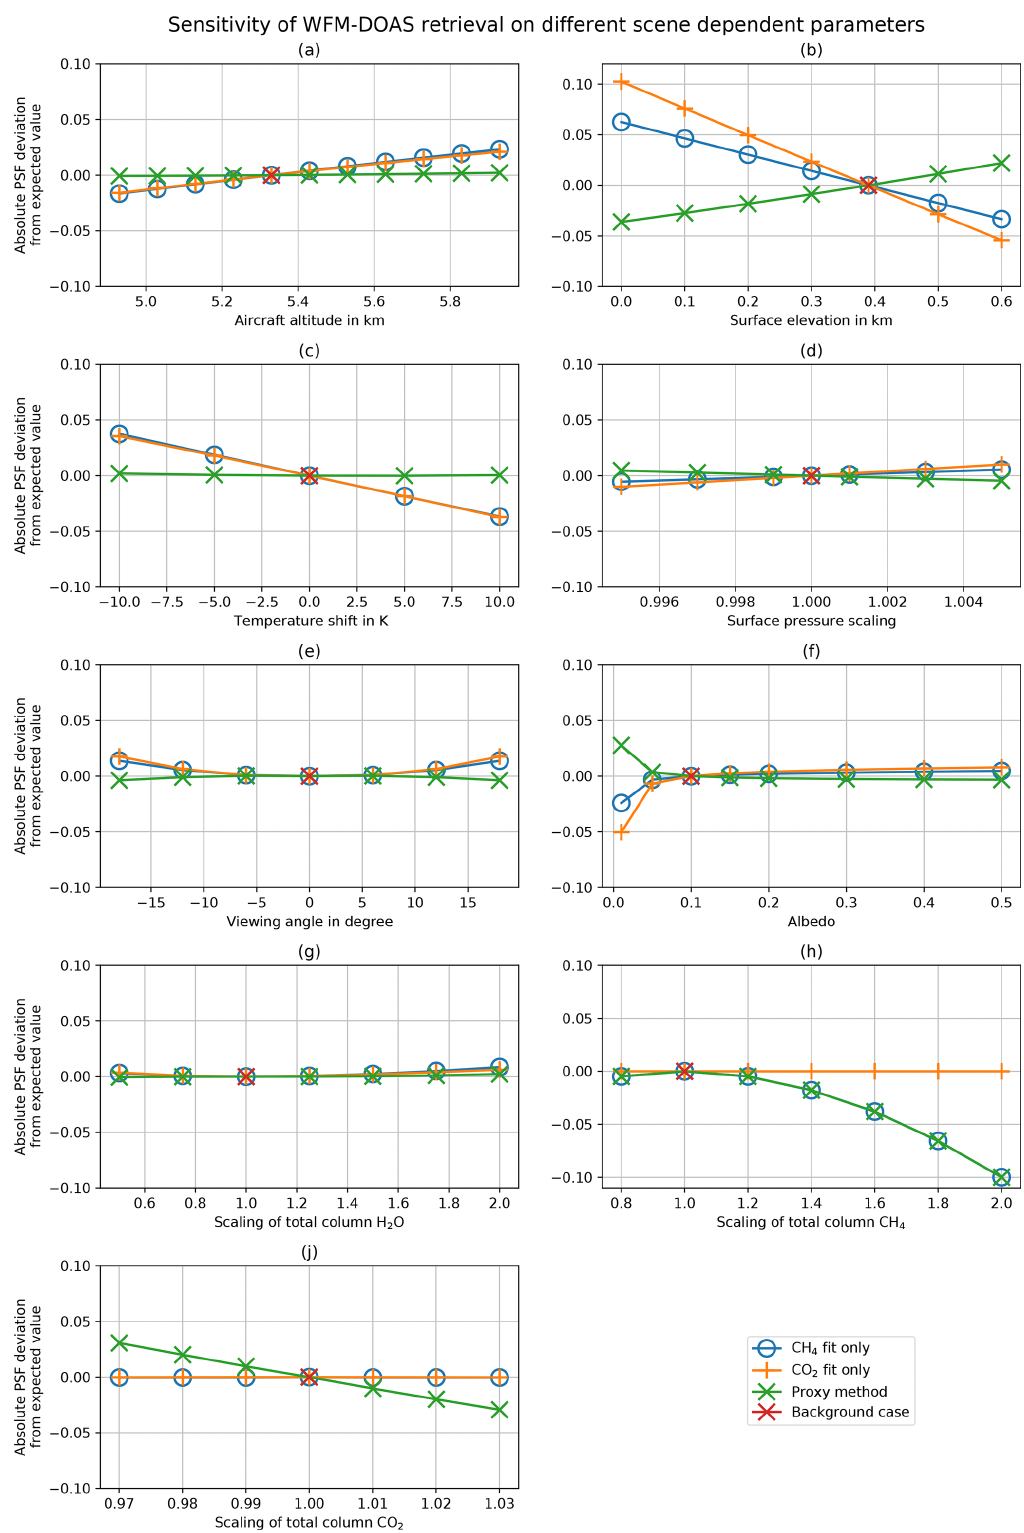
Figure 4. Sensitivity analysis of WFM-DOAS to the examined input parameters of the SCIATRAN radiative transfer calculation. The absolute deviation between the retrieved and the expected PSF CH parameter. With the proxy method, the deviations are reduced for all parameters except for scaling in the total columns. For deviations in CO 2 , the proxy is worse than the single CH 4 retrieval (see also Sect.